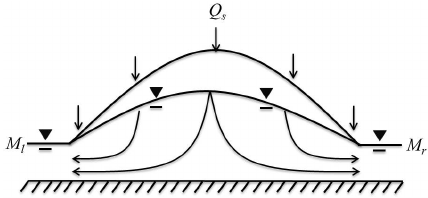
Figure 2. Schematic of a simple profile with a Dirichlet bound- ary condition on the right (M r ) , a no-flow boundary condition on the left, a constant source ( Q s ), and steady-state, variably saturated groundwater flow. In the theory, the vertical and horizontal extents of the cross section are assumed to be constant.